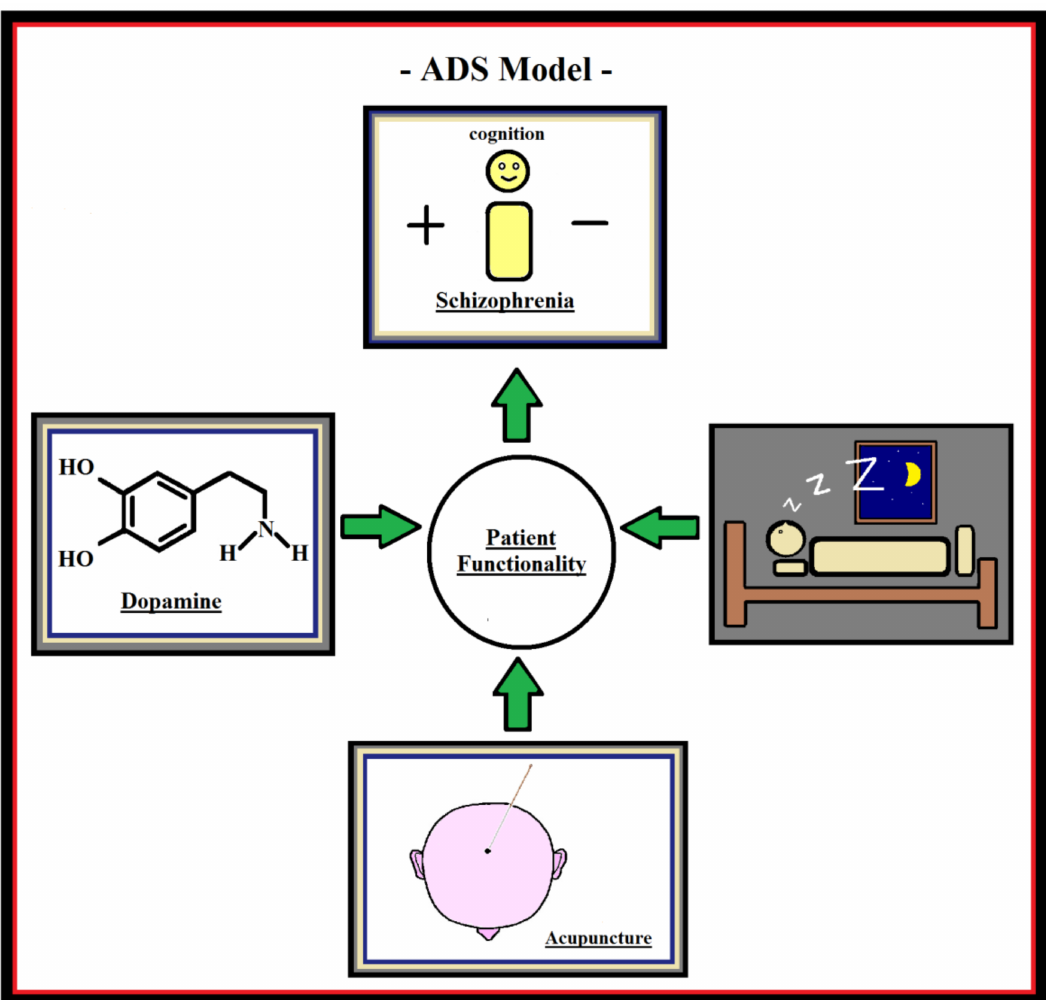
Figure 2. The ADS-model. Acupuncture is able to normalize the dopamine system, which is known to play a role in sleep regulation; thus, by improving sleep, acupuncture is beneficial for a patient suffering from schizophrenia and accompanying sleep